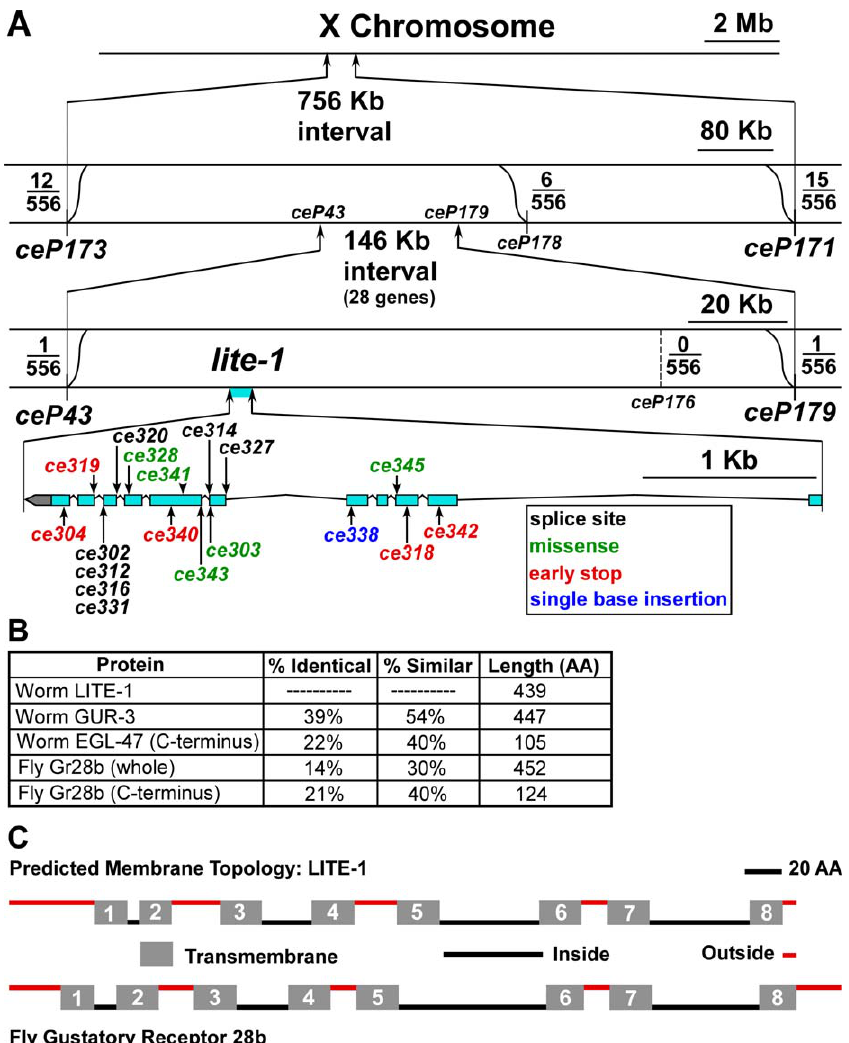
Figure 7. lite-1 Mutations Disrupt an Eight-Transmembrane Protein with Homology to Insect Gustatory Receptors. (A) Mapping data. Scaled low to high resolution drawings show SNP markers used to map the mutations. Supplementary Table 2 precisely describes each mutation. (B) LITE-1 is similar to two other C. elegans proteins and fly gustatory receptors. (C) LITE-1 has a predicted membrane topology that is similar to its closest fly paralog. Scale drawings show TMHMM2.0–predicted transmembrane regions [62].